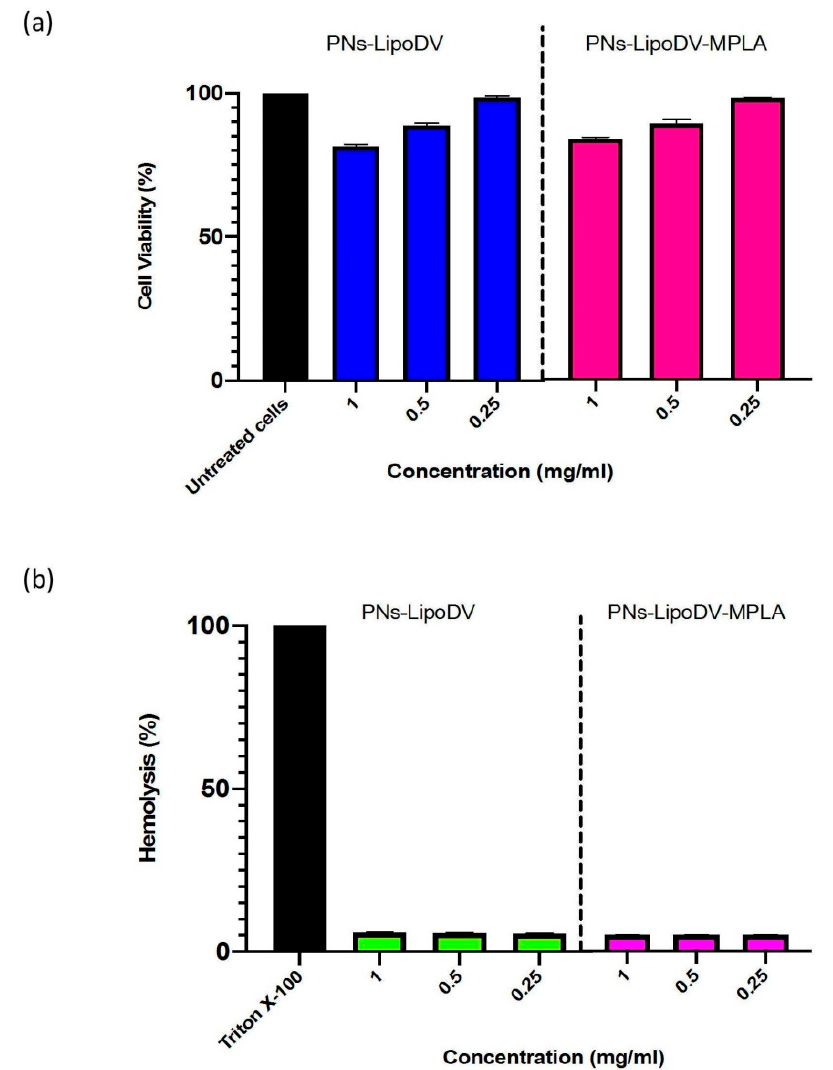
Figure 4. Cell viability analysis via MTT assay against HEK293 cells for 48 h as compared to the control cells (untreated cells, 100%) ( a ) and the hemolytic activity of formulated PNs vaccines at different concentrations range towards human red blood cells ( b ).